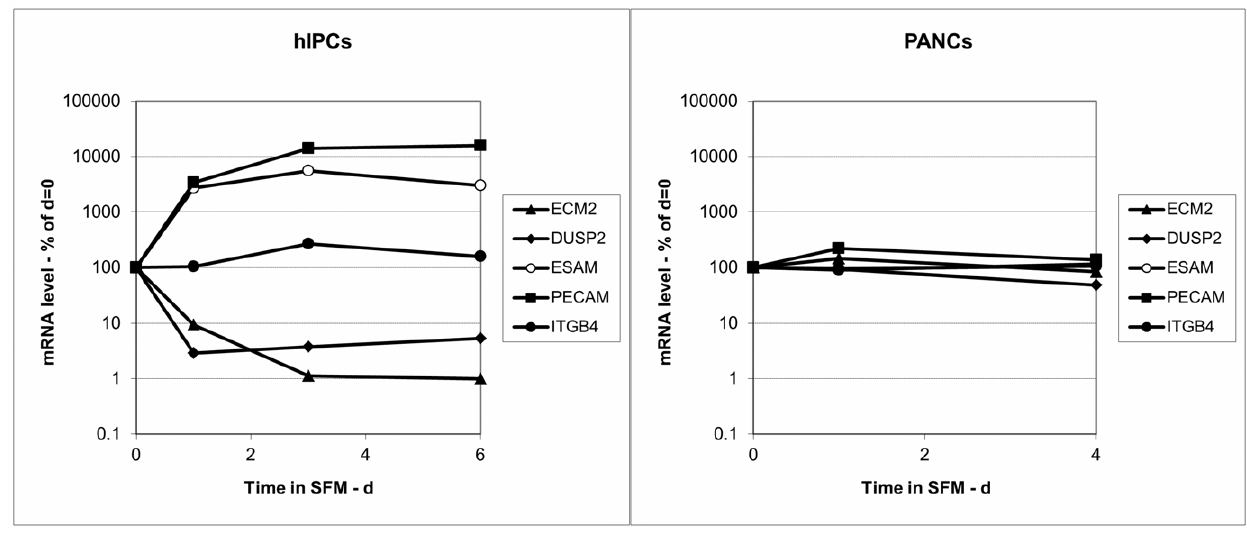
Figure 5. Kinetics of changes in expression of RUNX-controlled genes. A. hIPCs and B. PANC-1 cells were either cultured in serum-containing medium (t=0) or for the indicated times in serum-free medium. RNA was extracted and qRT-PCR performed as described in Materials and Methods. Results are presented as % change in mRNA levels of the indicated genes as a function of time in serum-free medium.